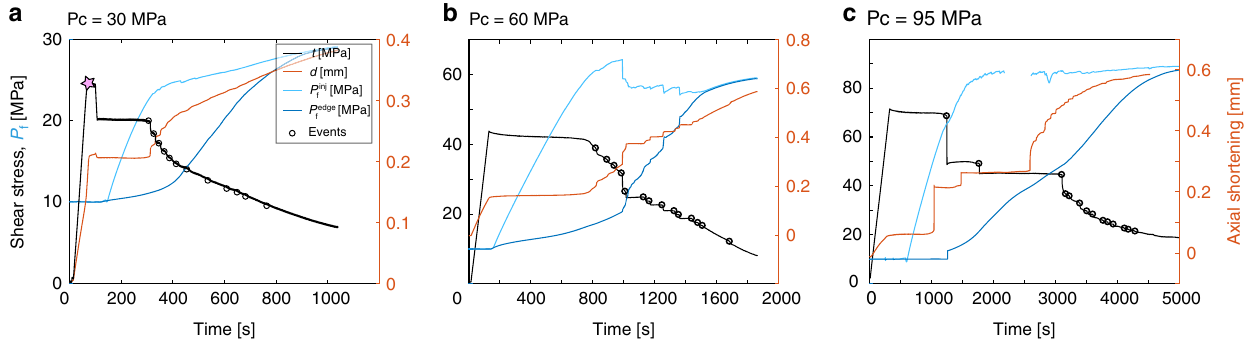
Fig. 2 Triggering of instabilities along a critically loaded crack. Evolution of the macroscopic shear stress and of the total axial shortening recorded by external gap sensors during experiments conducted at 30 ( a ), 60 ( b ) and 95 ( c ) MPa con fi ning pressure. The data presented in fi gure a include also the loading up to the peak strength of the fault, denoted by the pink star. Before each injection, the shear stress was fi rst placed at 90% of the peak strength of the fault. Then, fl uid was injected at a constant volume rate into the injection borehole (Supplementary Fig. 1a), up to the release of the energy stored in the system. Black, red, cyan and blue solid lines correspond to the evolution of the shear stress, the fault slip, the fl uid pressure in the injection borehole and the fl uid pressure in the measurement borehole, respectively. Black circles correspond to each slip instability treated in this study. The missing data in panel c are related to experimental maintenance of the fl uid pressure system. The fl uid pressure during this period is constant along the experimental